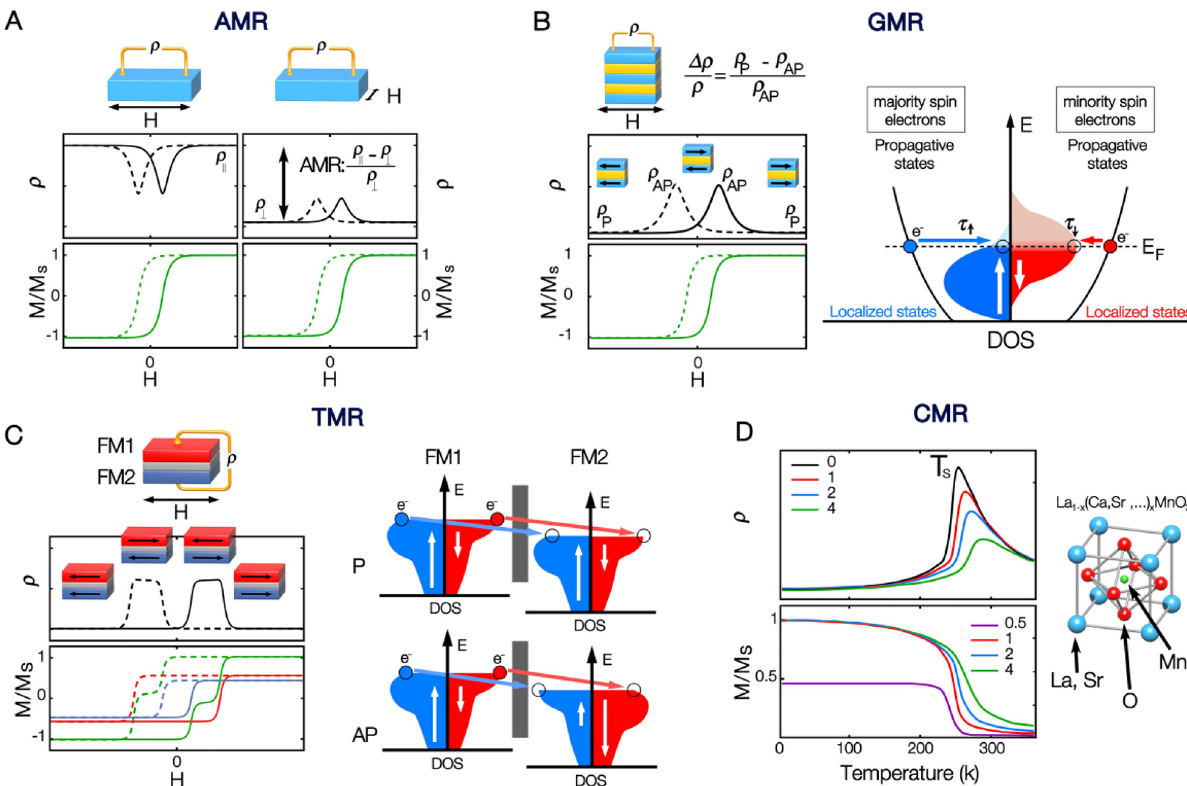
Figure 2: Four spintronic phenomena leading to MRE. (A) Anisotropic magnetoresistance (AMR): black and green curves represent, respectively, the dependence of electrical resistivity and magnetization on the applied magnetic field for a ferromagnetic layer. The magnetic field varies from positive to negative (dotted lines) or from negative to positive (full lines). (B) Giant magneto resistance (GMR): Left panel. - black and green curves represent, respectively, the dependence of electrical resistivity and magnetization on the applied magnetic field for a ferromagnetic/non ferromagnetic metallic multilayer. The magnetic field varies from positive to negative (dotted lines) or from negative to positive (full lines). Right panel. - Schematic representation of the Density of States (DOS) of a multilayer in the P state for different types of electrons. (C) TunnelMagneto Resistance (TMR) : Left panel. - Black curves representthe dependence of the tunnel resistivity onthe magnetic field, whereas the green, red and blue curves represent the dependence of the total magnetization and the magnetizations of the FM1 (representedinred)andFM2(representedinblue)layersonthemagneticfield,respectively.Theinsulatorspacerlayeris representedingrey. Themagneticfieldisappliedintheplaneandvariesfrompositivetonegative(dottedlines)orfromnegativetopositive(fulllines).Rightpanel. - Schematic representation of the DOS of all the electrons, for the parallel (P) and antiparallel (AP) configurations, for the two ferromagnetic electrodesFM1andFM2,respectively.Theblue(red)regionscorrespondtotheelectronswhosespinpointstothepositive(negative)direction. The blue and red arrows represent the tunnel current of each spin channel. (D) Colossal Magnetoresistance (CMR) (From ref [29], https://doi. org/10.1103/PhysRevLett.75.3336, with permission): Left panel. - Resistivity (upper graph) and magnetization (lower graph) as a function of the temperature for different values of the applied magnetic fi eld. The values of the magnetic fi eld in Tesla along with the corresponding line colors are indicated in each graph. Crystal structure of a representative CMR